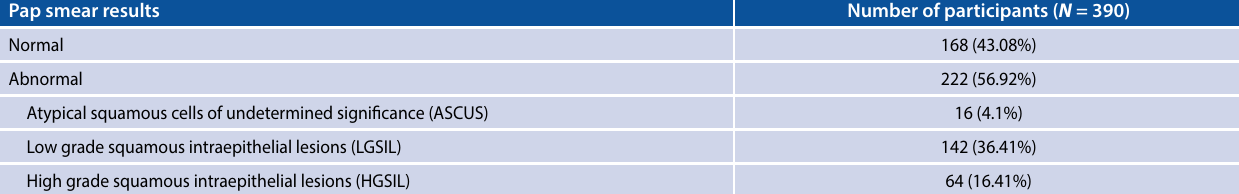
Table 4: Current Pap smear results of the study’s participants Pap smear